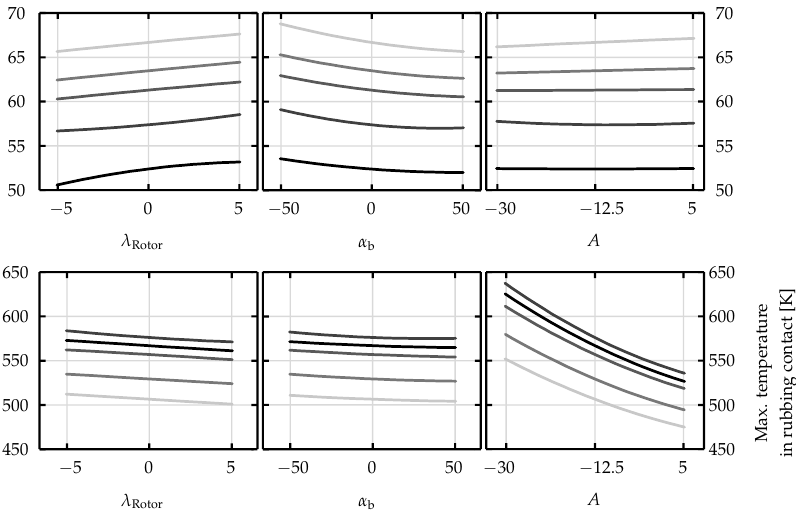
Figure 11. Main effect diagrams for heat flux distribution ( top ) and maximum temperature in rubbing contact ( bottom ); ∆ p = 1.0bar ( ) − ∆ p = 7.0bar (